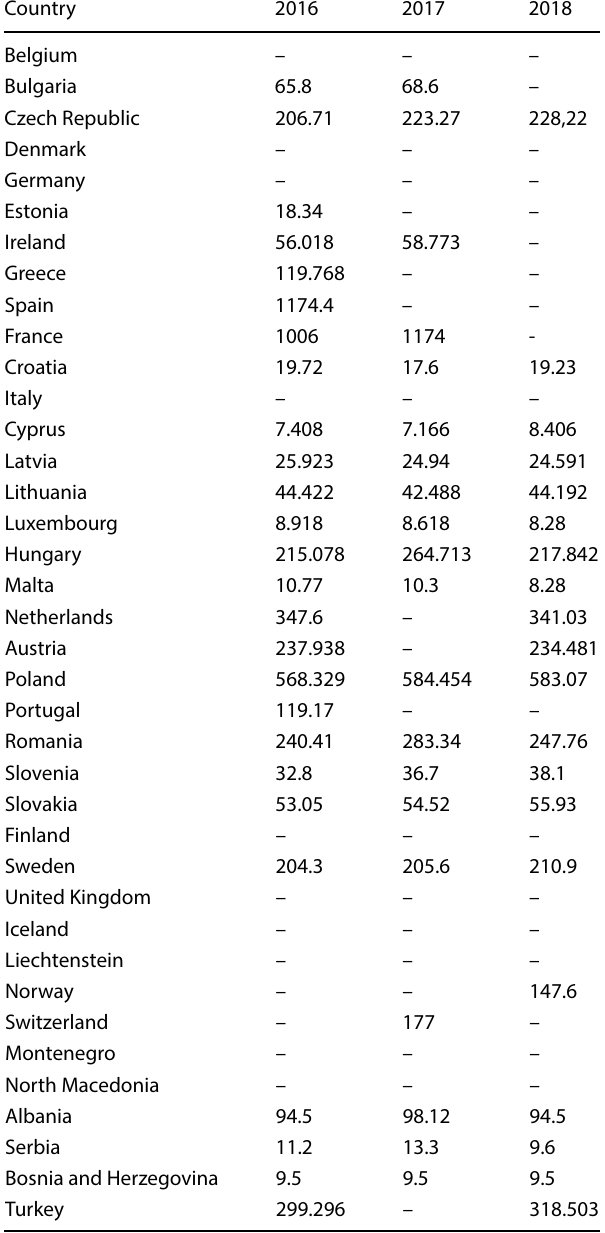
Table 1 Annual production of sewage sludge (unit of measure in thousand of tonnes) in Europe, by country, during 2016–2018